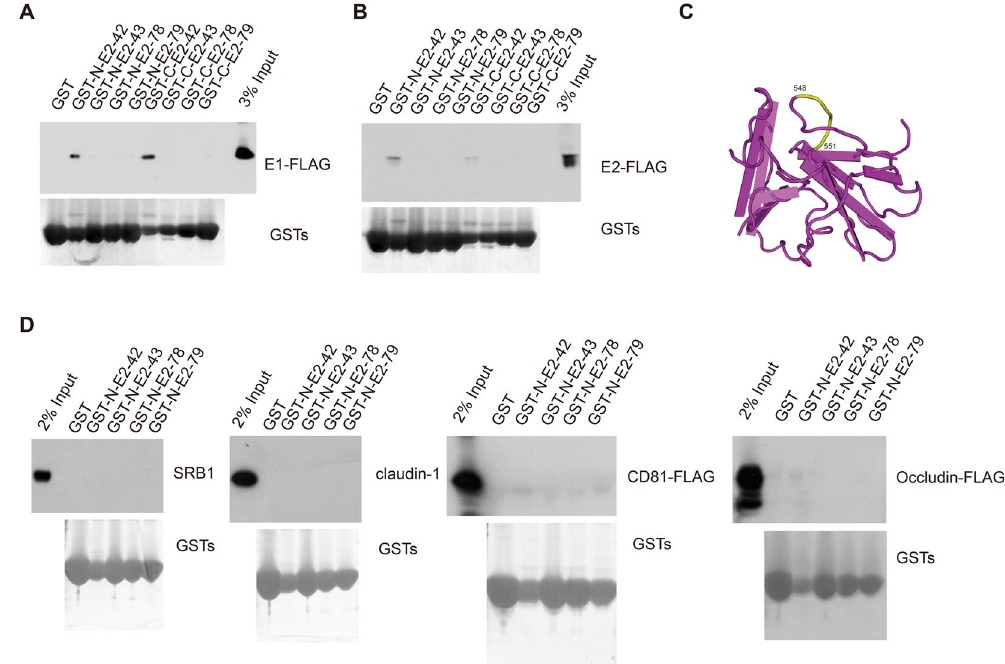
Figure 6. E2-42 interacts with HCV envelope proteins. ( A ) GST pulldown revealed that E2-42 associated with E1. Cell lysates from 293 T cells expressing JFH1 E1-FLAG were incubated with purified GST-N-E2-42, GST-N-E2-43, GST-N-E2-78, GST-N-E2-79, GST-C-E2-42, GST-C-E2-43, GST-C-E2-78, GST-N-E2-79 or GST, and the proteins were pulled down with glutathione-Sepharose beads. Bound proteins were detected by immunoblotting using anti-FLAG antibody. ( B ) GST pulldown identified an association between E2-42 and E2. Cell lysates from 293 T cells expressing JFH1 E2-FLAG were incubated with purified GST-N-E2-42, GST-N-E2-43, GST-N-E2-78, GST-N-E2-79, GST-C-E2-42, GST-C-E2-43, GST-C-E2-78, GST-N-E2-79 or GST, and the proteins were pulled down with glutathione-Sepharose beads. Bound proteins were detected by immunoblotting using anti-FLAG antibody. ( C ) Residues 548-551 of E2 is exposed in E2 structure. Ribbon representation of partial E2 model structure (PDB ID:4WHT) with residues 548–551 highlighted in yellow. ( D ) GST pulldown confirmed that E2-42 does not interact with HCV receptors. Cell lysates from Huh7.5.1 or 293 T cells expressing CD81-FLAG or occludin-FLAG were incubated with purified GST-N-E2-42,